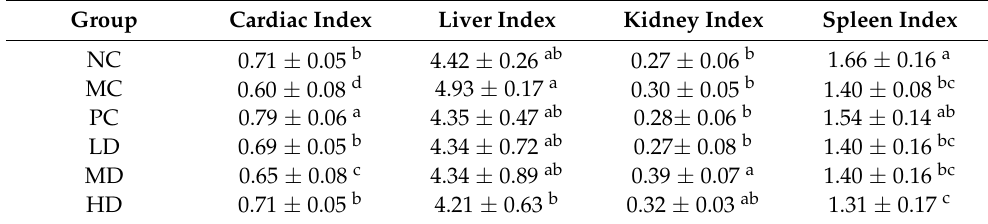
Table 2. Organ index in mice fed experimental diets for 30